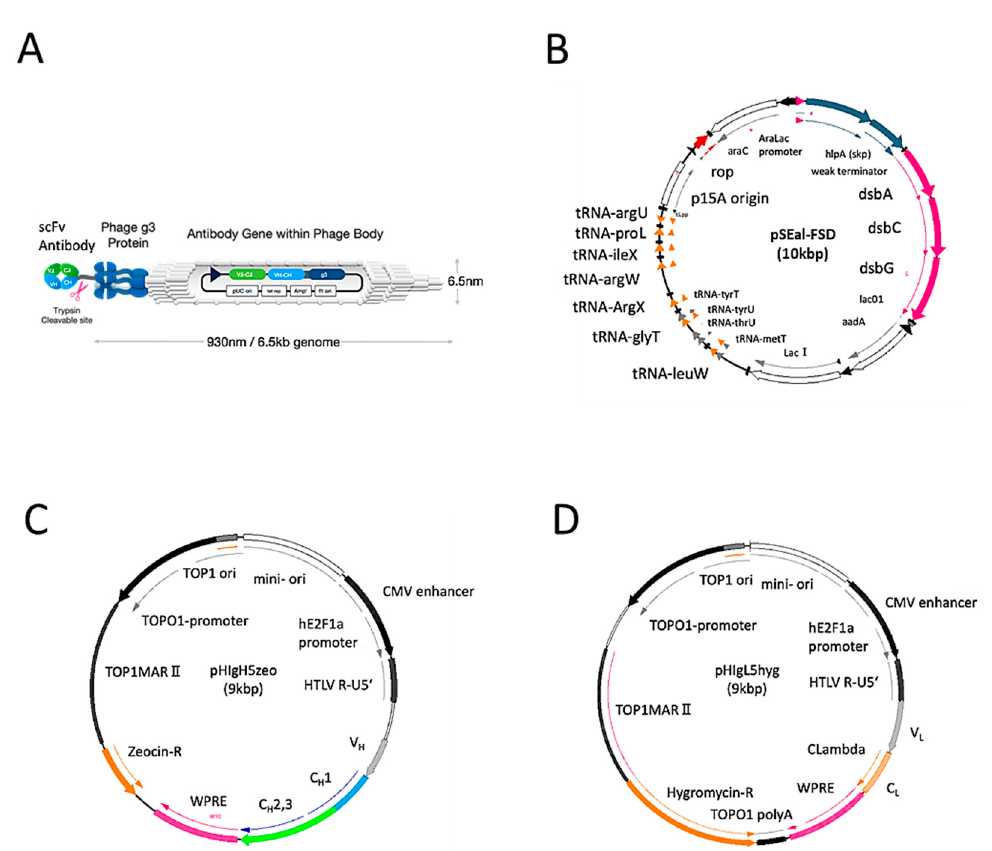
Figure 1. Vector information of phage library and Human IgG: ( A ) schematic structure of a phage displaying scFv; ( B ) the structure of plasmid pSEaL-FSD4 harbored in E. coli XL1Blue; ( C ) the structure of plasmid pHIgH5zeo conveying the DNA sequences for human IgG V H region followed by C H region consisting of C H 1, C H 2 and C H 3 with a zeocin resistant gene; and ( D ) the structure of plasmid pHIgL5hyg conveying the DNA sequences for human IgG V L region followed by C L with a hygromycin resistant gene. See text for more details.